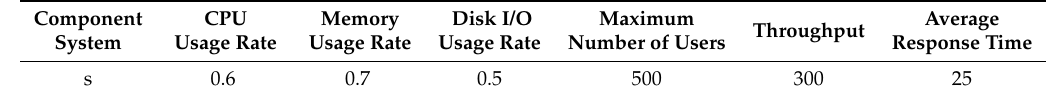
Table 10. The target value of the metric